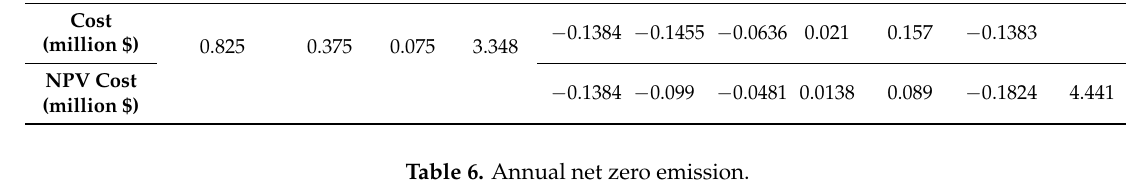
Table 6. Annual net zero emission.